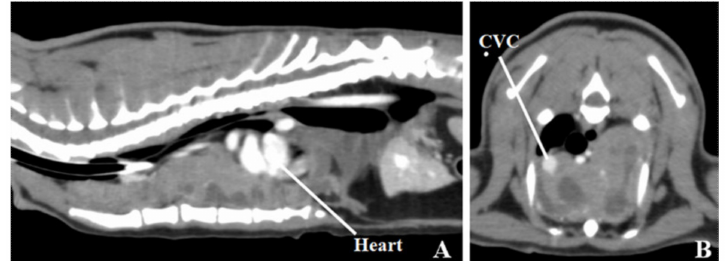
Figure 1. A contrast computed tomography image of the thorax. ( A ) Sagittal image. ( B ) Transverse image at level fifth thoracic vertebra. A large mass is present with contrast-enhancing soft tissue-attenuating regions and noncontrast low-attenuating regions with suspected fluid retention in the ventral thoracic cavity. The heart is displaced caudally and to the right. Arterial vessels in the precordium (brachiocephalic trunk, left subclavian artery) are moved dorsally by the mass. The cranial vena cava (CVC) is moved to the right by the